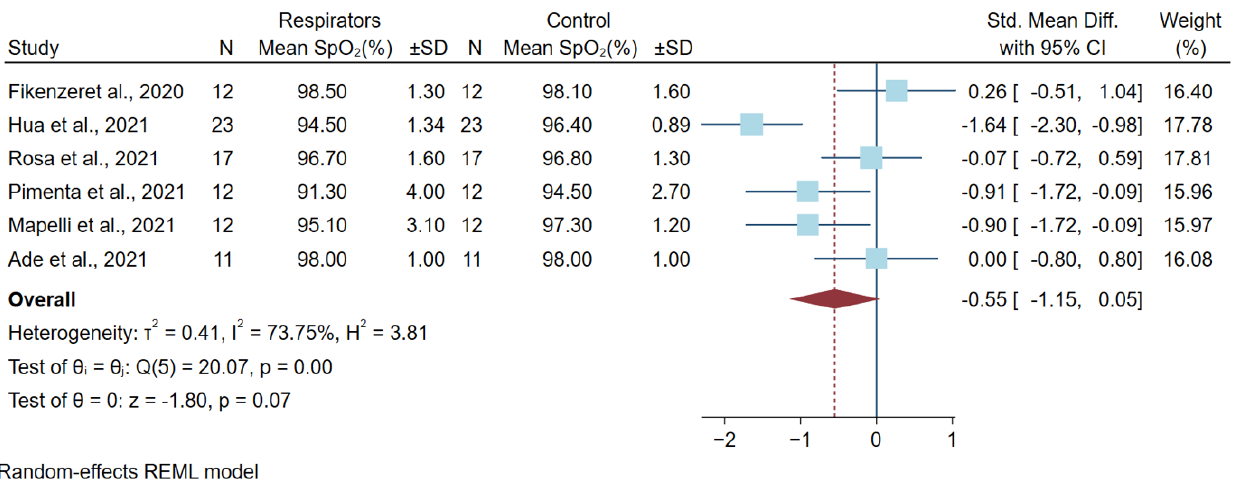
Figure 2. Difference in Oxygen Saturation Levels after a High Physical Workload. Abbreviations: CI, confidence interval; SD, standard deviation; SpO 2 , oxygen saturation level; Std. mean diff., standard mean difference [4,5,10 – 13].